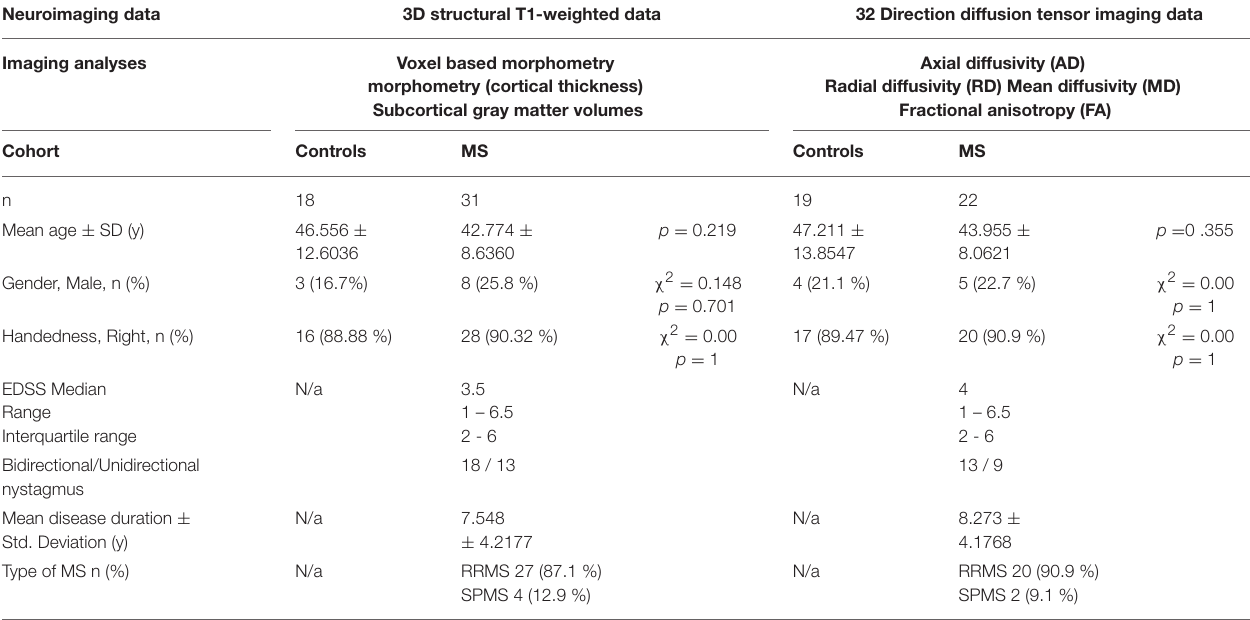
TABLE 1 | Demographic and clinical characteristic of patients and healthy controls. Neuroimaging